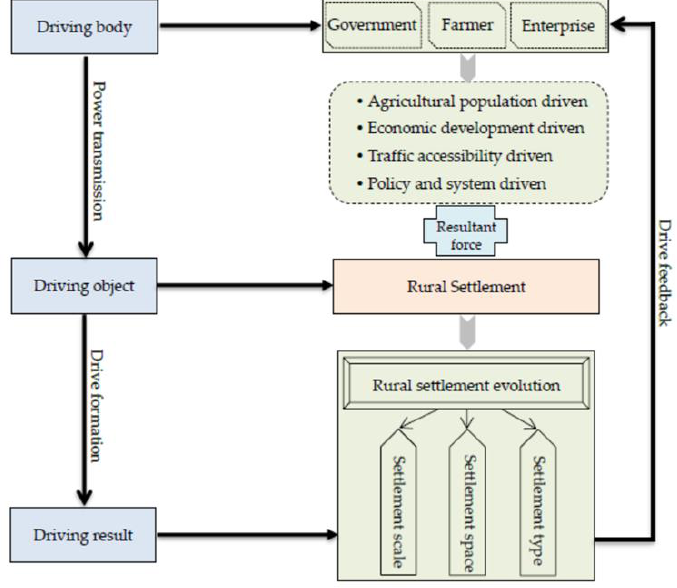
Figure 6. Theoretical framework of settlement evolution driving mechanism.